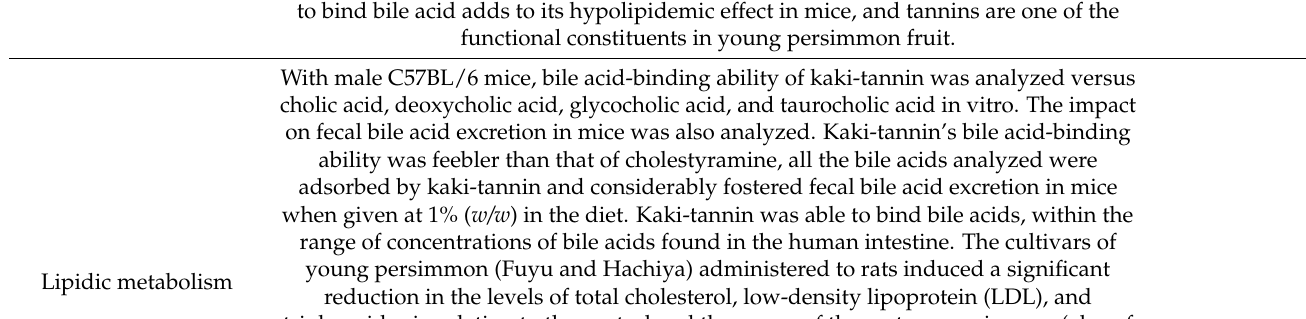
Table 3. Some scientific works in vitro, in vivo, and in humans demonstrating biological effects related to Diospyros kaki L and D. Lotus L. Target Biological Effect (s)